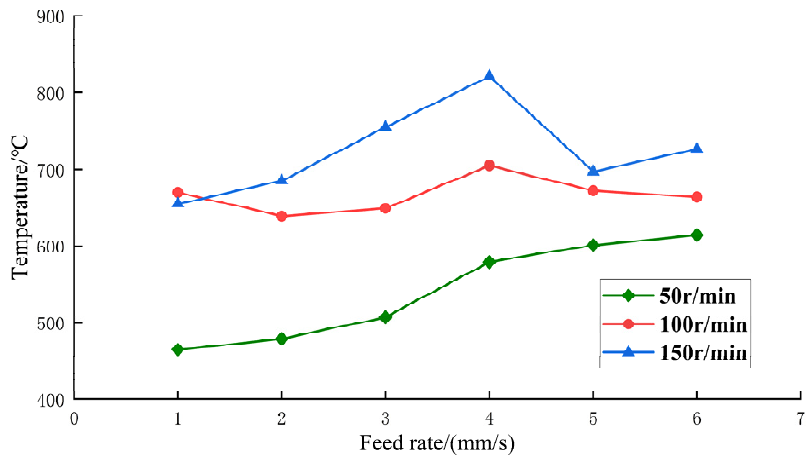
Figure 13. Effect of feed rate on sawing temperature.